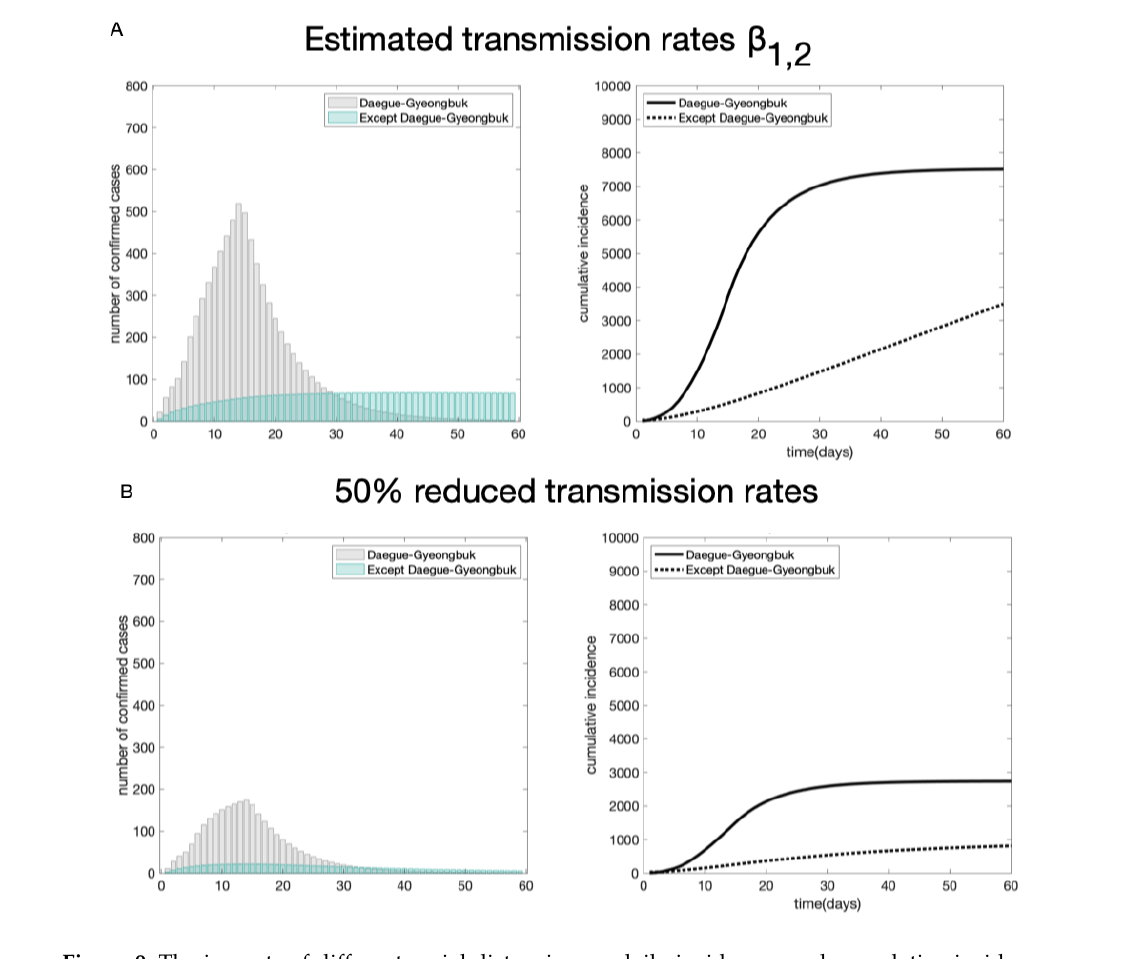
Figure 9. The impacts of different social distancing on daily incidences and cumulative incidences. ( A ) Effect of not strict social distancing assuming estimated transmission rates on the incidences. ( B ) Effect of more strict social distancing assuming 50% of transmission rates on the